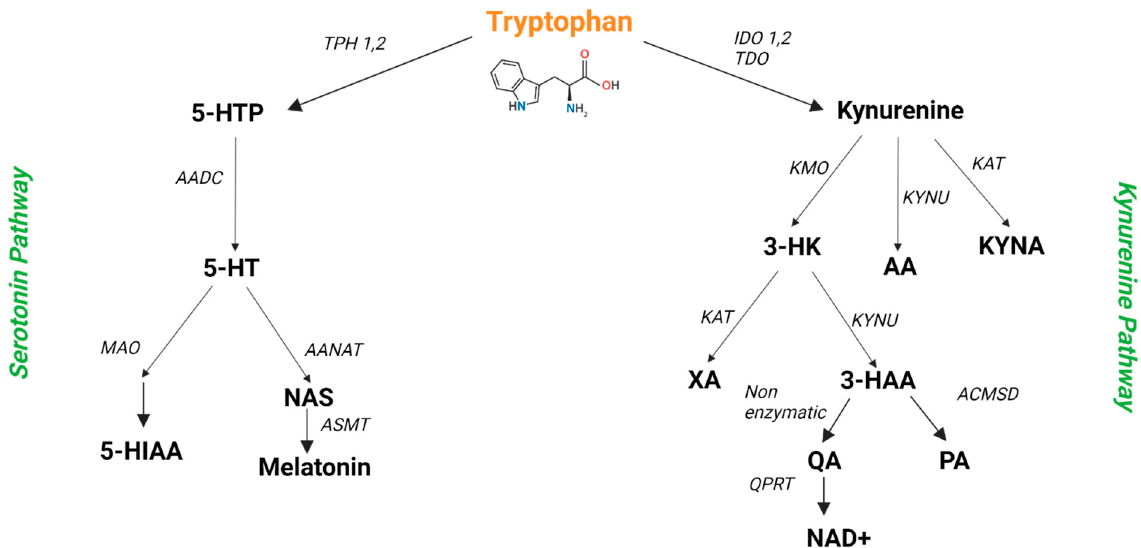
Figure 3. Summary of the two major metabolic pathways of the amino acid Trp: 5-HT and Kyn pathways. All of the abbreviations are described in text. Illustration created with BioRender [8].